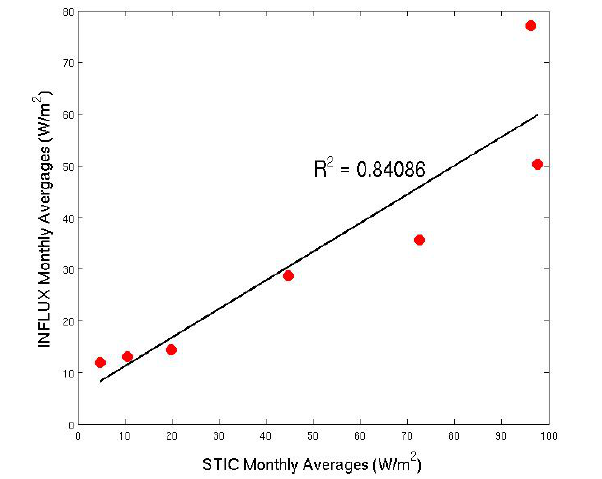
Figure 2: Flow chart depicting the algorithm used to calculate the surface resistance values. The green shapes represent input, the yellow shapes represent processes, and the red shapes represent outputs. Also, the arrows range from light blue to dark blue, each colour representing a new group of steps in the process (dark blue shows the final steps).